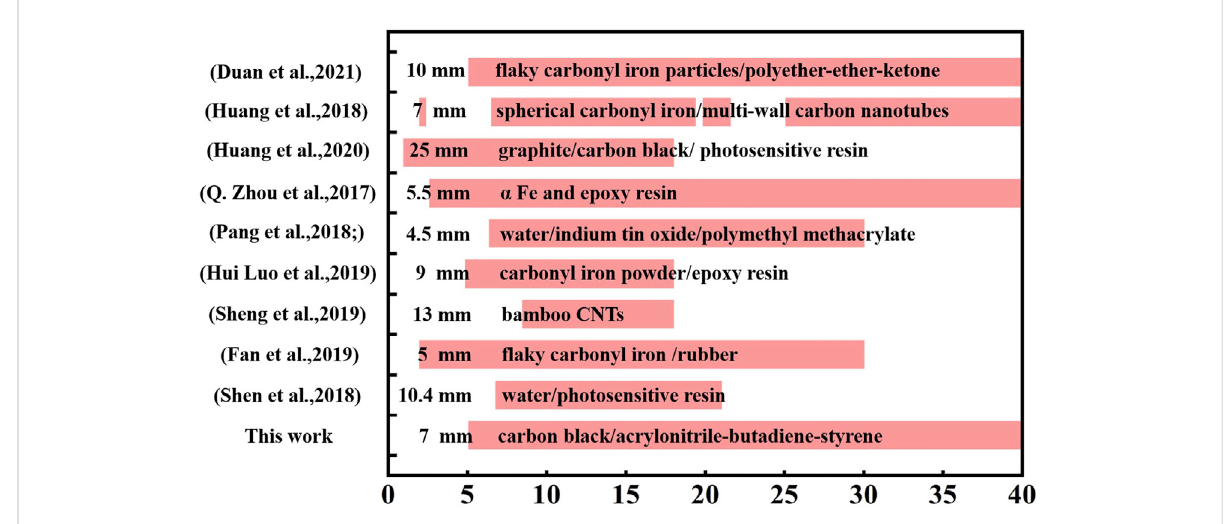
FIGURE 5 Comparison of − 10 dB absorption bandwidth range between this work and previous